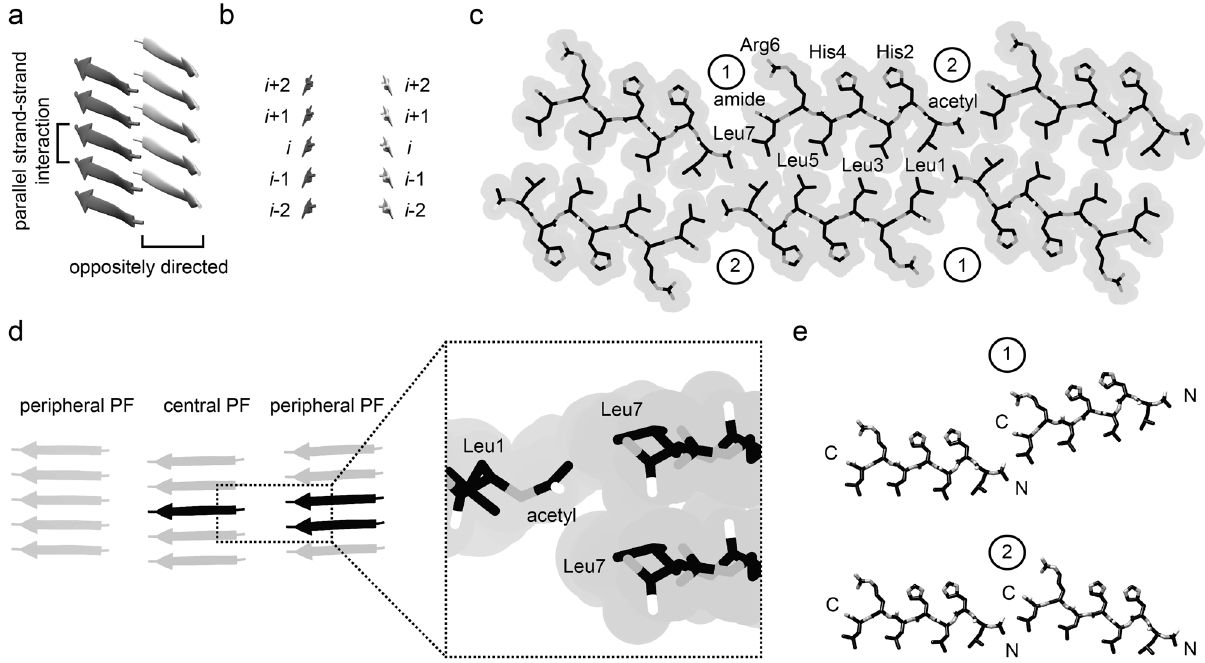
Figure 2. Packing of the peptides in the fibril. ( a ) Ribbon diagram of five molecular layers of the central PF. Parallel strand-strand interactions occur within the same β-sheet. Strands in the same molecular layer of the two β-sheets are oppositely directed. ( b ) Ribbon diagram of layers i – 1 to i + 1 of the central PF, viewed along the strands. The two sheets are not staggered relative to one another. ( c ) Cross-sectional view of a stick model of one molecular layer of the fibril, superimposed with the outline of the van der Waals surface (grey). ( d ) Side view of the proximal β-sheets of the three PFs, showing the staggering of adjacent PFs. Close up: Contact site of two PFs. ( e ) There are two peptide-peptide contact modes (1 and 2) as labelled in panel ( c